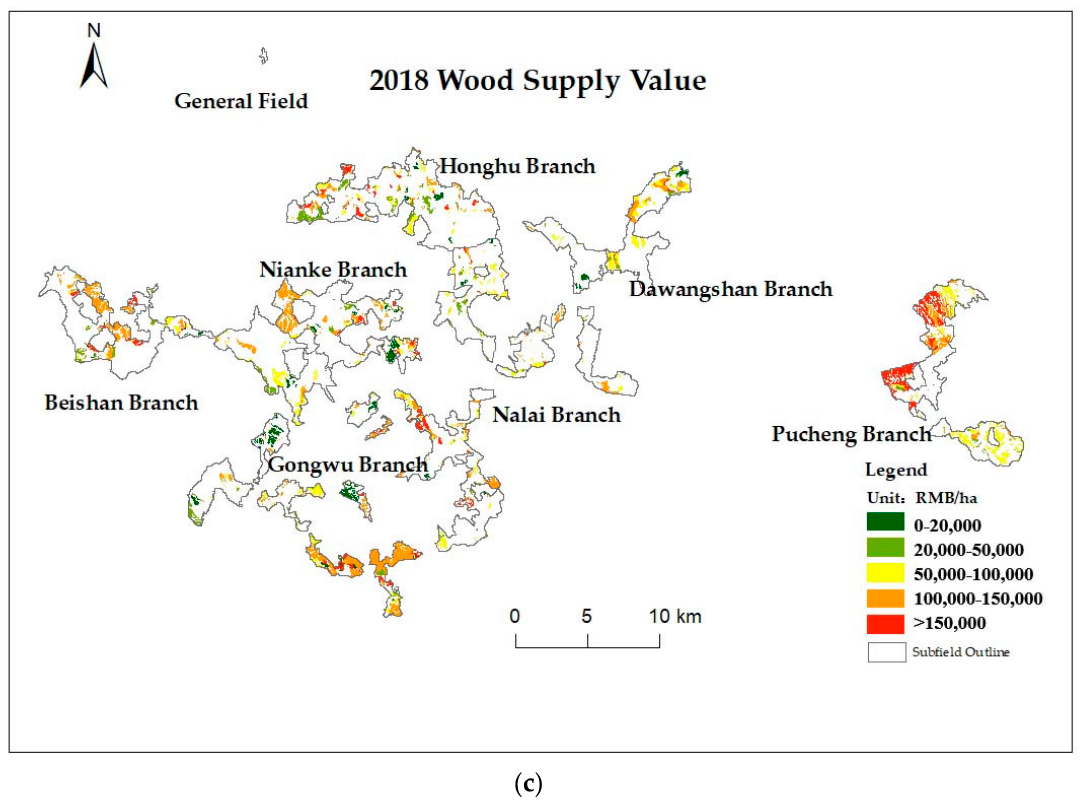
Figure 2. Spatial distribution map of the wood supply value for PM plantations in the northern tropical case study area in 2009–2018. ( a ) 2008 Wood supply value; ( b ) 2013 Wood supply value; ( c ) Wood supply value.